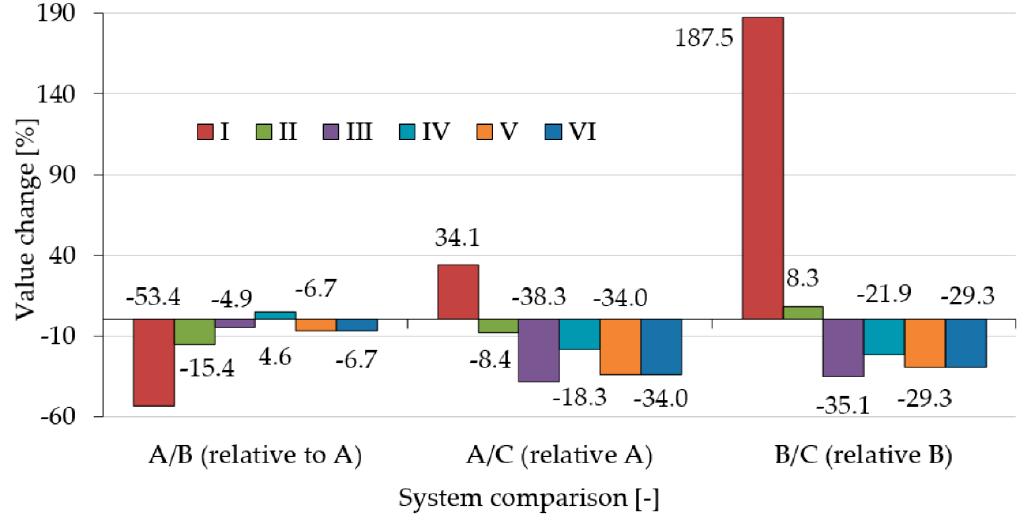
Figure 10. Analysis of the impact of individual systems on the relative changes of selected values; compounds emission: I—HC, II—CO, III—CO 2 , IV—NO X ; V—Fuel consumption, VI—Fuel cost.